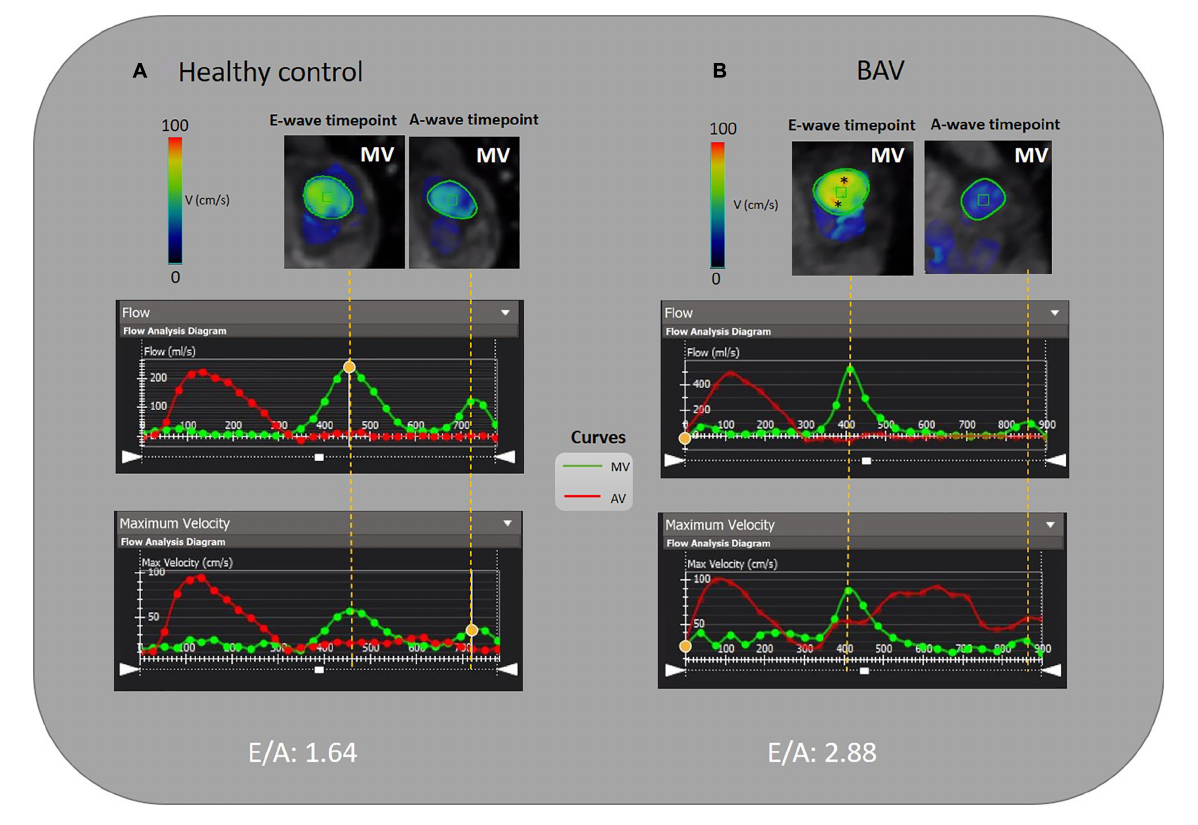
FIGURE2 E/A measurement by 4D flow MRI analysis. (A) A 46-year-old healthy female and (B) A 35-year-old BAV patient male with mild regurgitation. MV is contoured semiautomatically and dynamic MV plane was set throughout a cardiac cycle. The acquired flow-time diagram is turned into a peak velocity-time diagram to measure E and A-wave peak velocity and E/A. Asterisks (*) indicate increased velocity at E-wave timepoint in BAV with mild regurgitation compared to the healthy